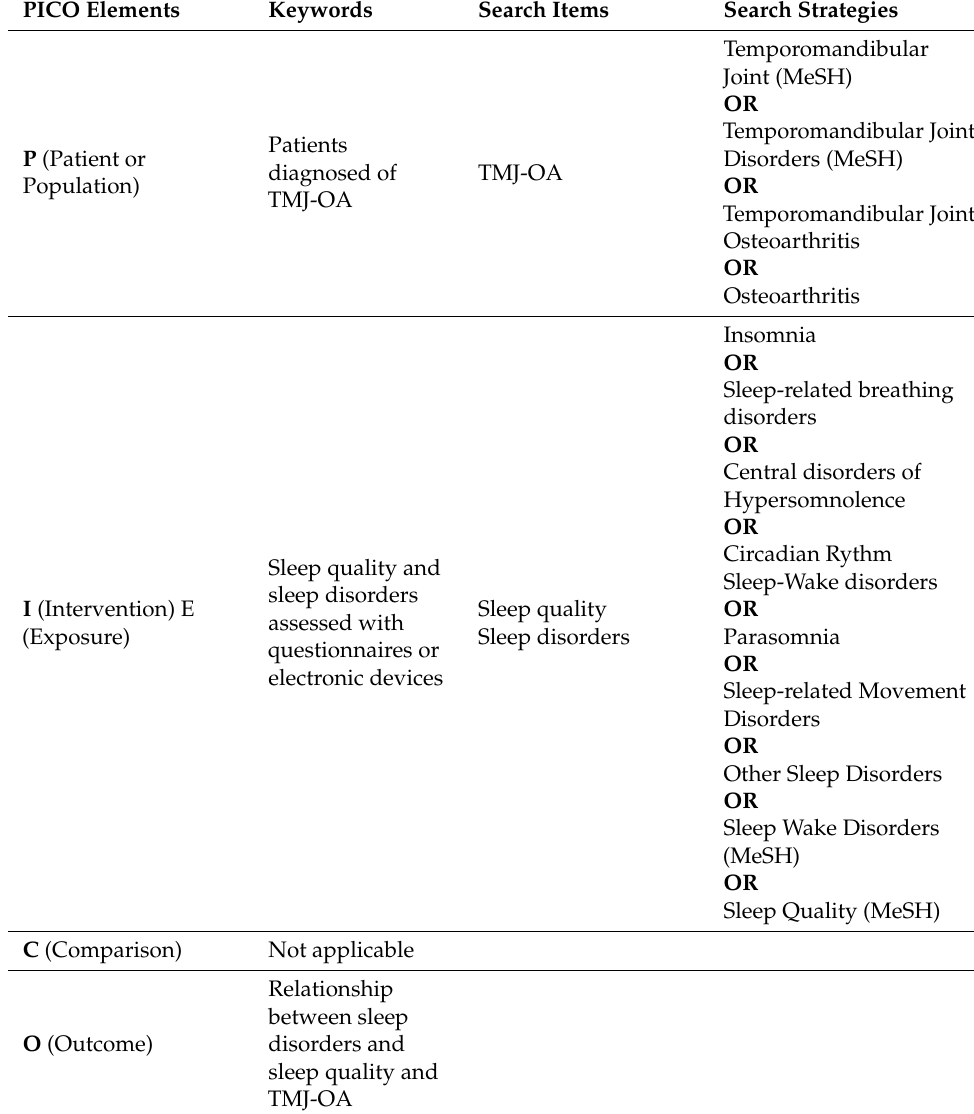
Table 1. PICO strategy